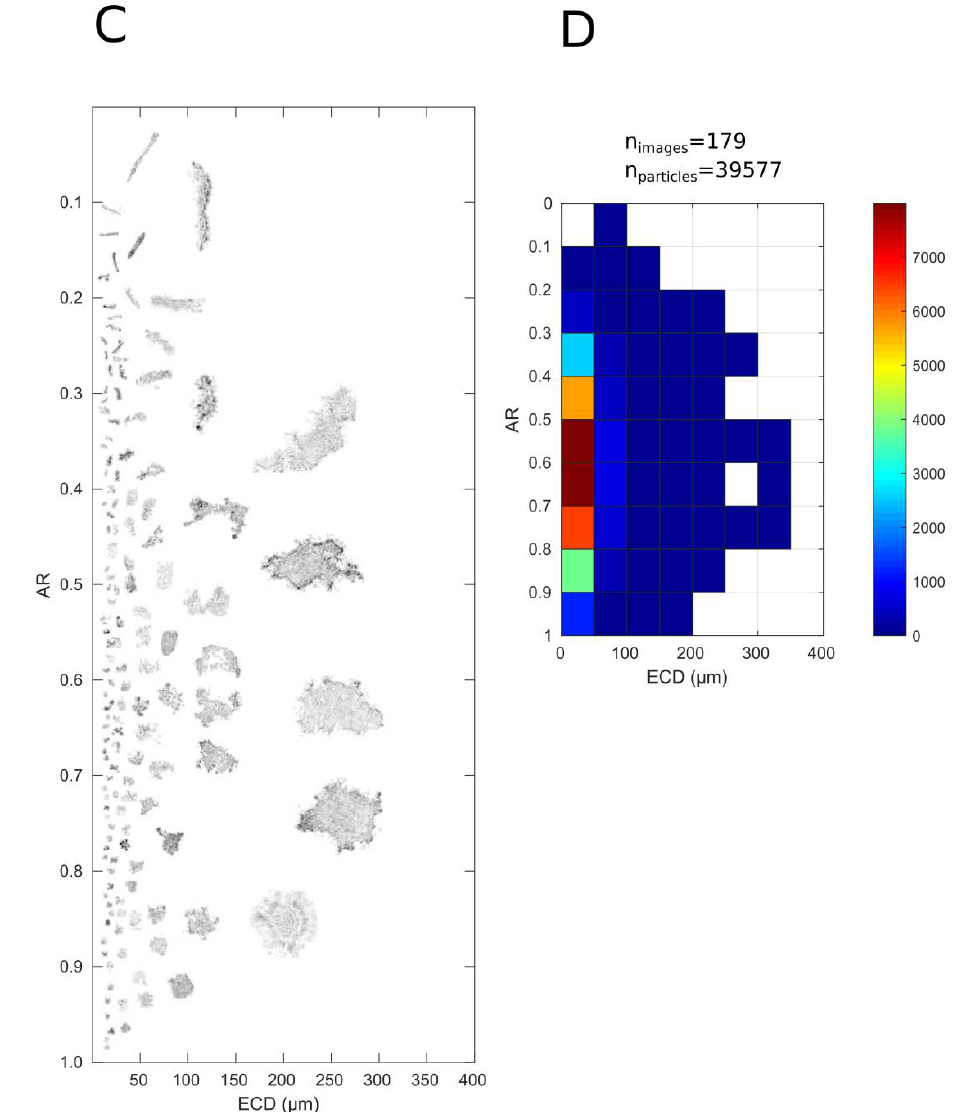
Figure 9. Examples of particle assemblages from the LISST-HOLO images ( A ) at the surface and ( C ) near the bottom for all stations of the across-bay section in August 2017. Variation of SPM aspect ratio (AR, dimensionless) as a function of the SPM equivalent circular diameter (ECD, µ m) at the surface ( B ) and the bottom layer ( D ). The corresponding particle number distribution per size class is shown on the right panels.